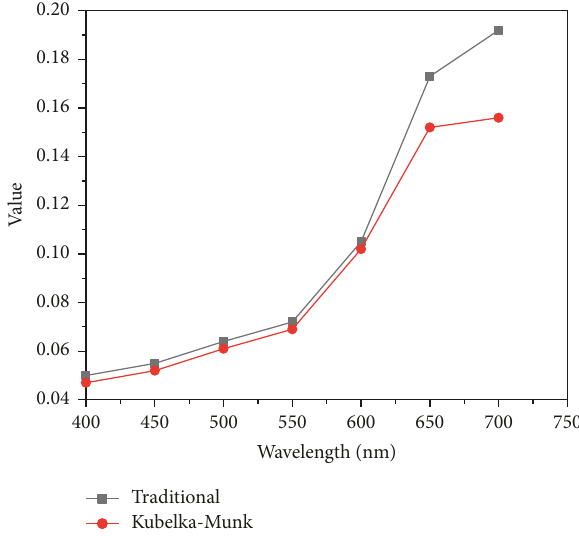
Figure 3: Fitting formula color error comparison chart (yellow silk).